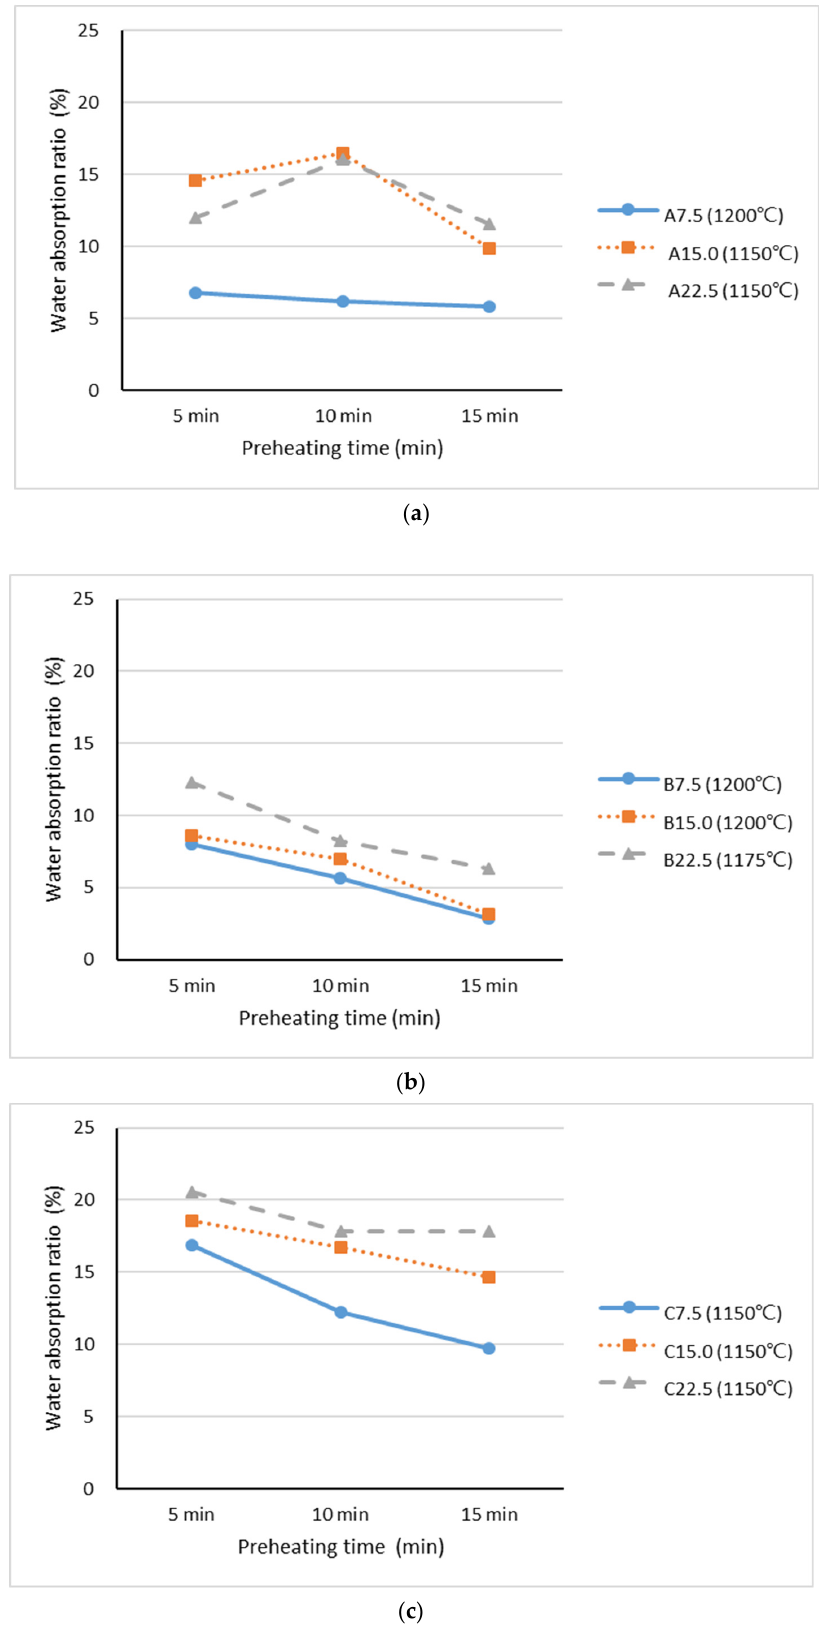
Figure 7. Water absorption ratios of lightweight aggregates at Stage II mixed with ( a ) Industrial Sludge A, ( b ) Industrial Sludge B, and ( c ) Industrial Sludge C. Sludge A, ( b ) Industrial Sludge B, and ( c ) Industrial Sludge